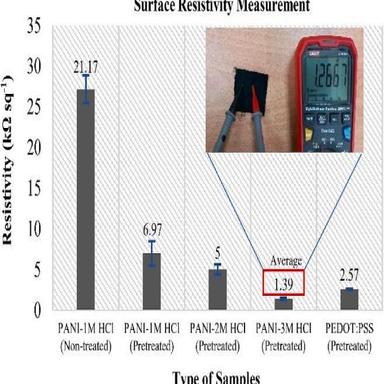
Resistivity PANI and PEDOT: PSS induced Cotton fabric at different dopant concentrations.